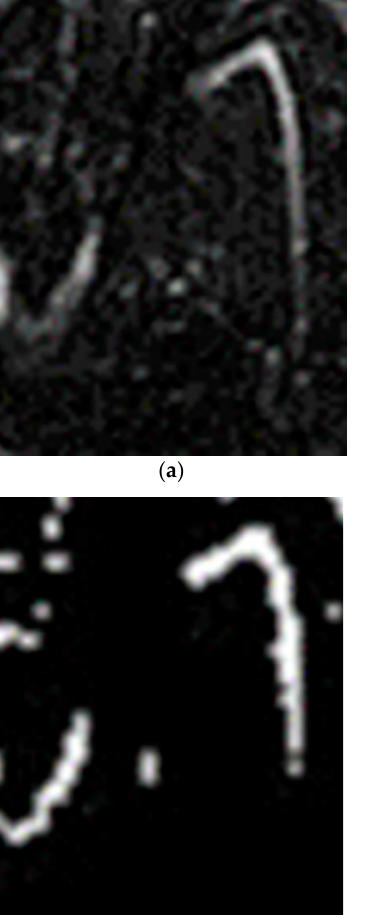
Figure 6. Percentage of IO-NPs of 10 slices from 3D MRI image.